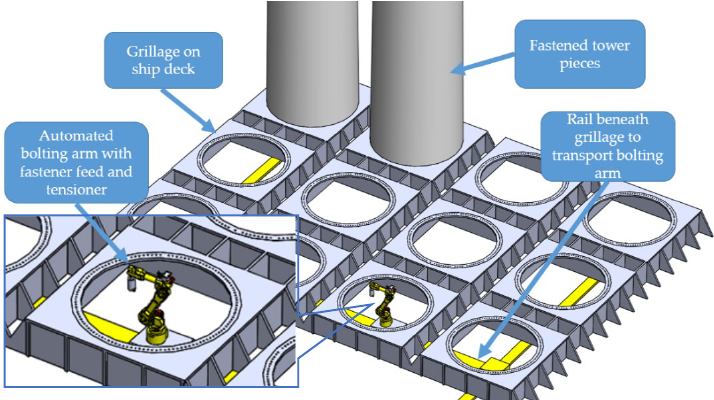
Figure 2. Automated bolted seafastening, concept illustration.